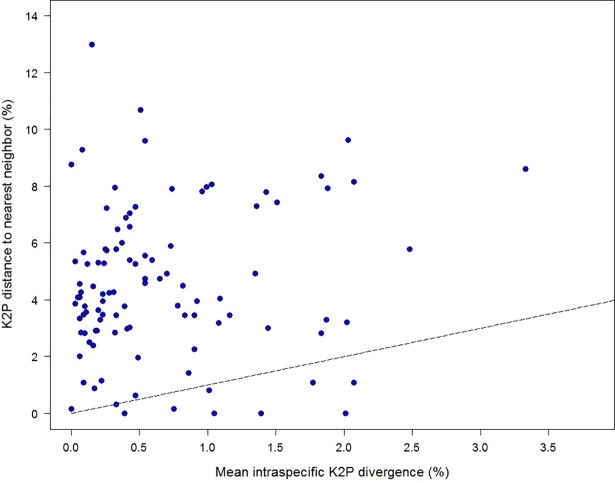
Mean intraspecific sequence divergences for 102 Lepidoptera species in relation to nearest neighbor.Barcode sequence distances to the nearest neighbor species in relation to mean intraspecific distances for 102 species of Palearctic Lepidoptera. The straight line indicates where distance to nearest neighbor equals the respective intraspecific distance, viz. for species above this line the ‘barcode gap’ does exist.